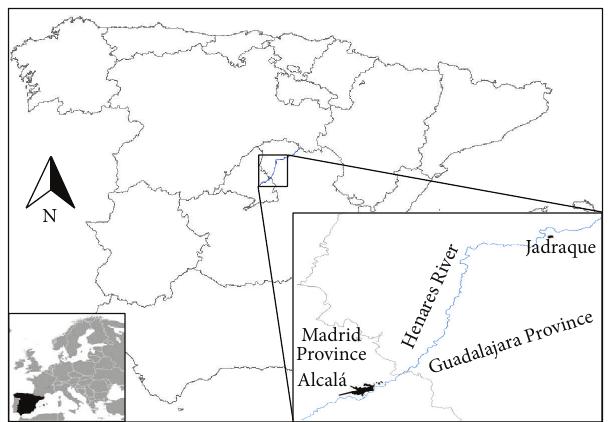
Figure 1: Map of the study sites (Jadraque and Alcal´a) along the floodplain of the Henares River, Central